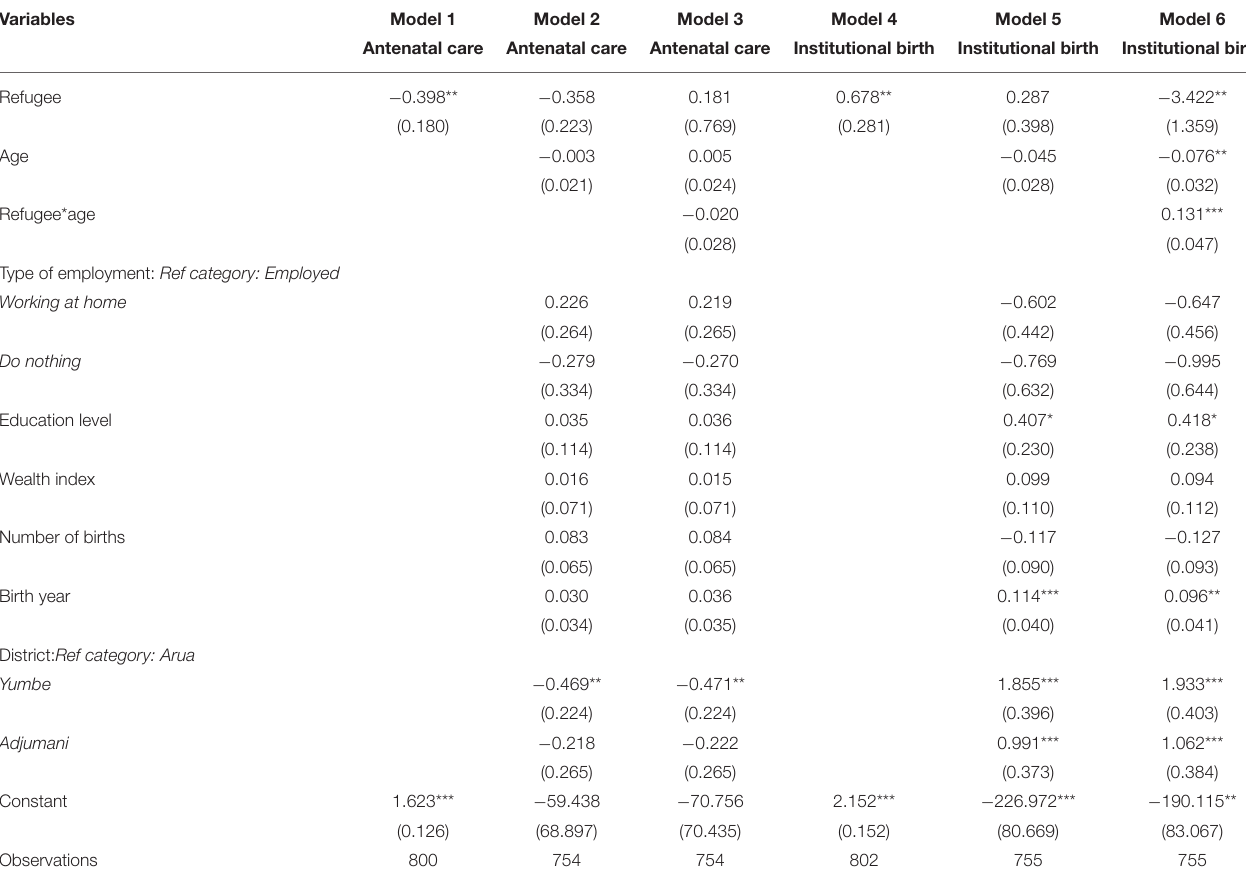
TABLE 2 | Logit regression testing access to antenatal care and institutional birth and refugee status.